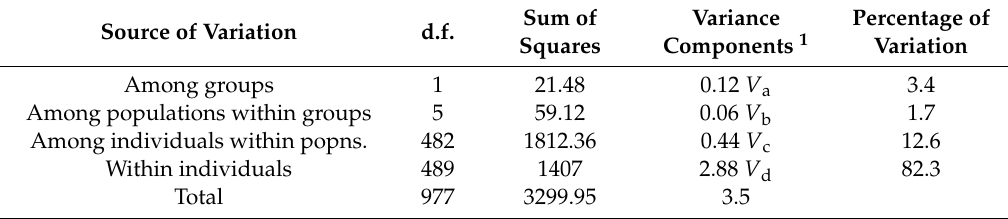
Table 7. AMOVA results for striped bass collections in the Roanoke River basin. Source of Variation